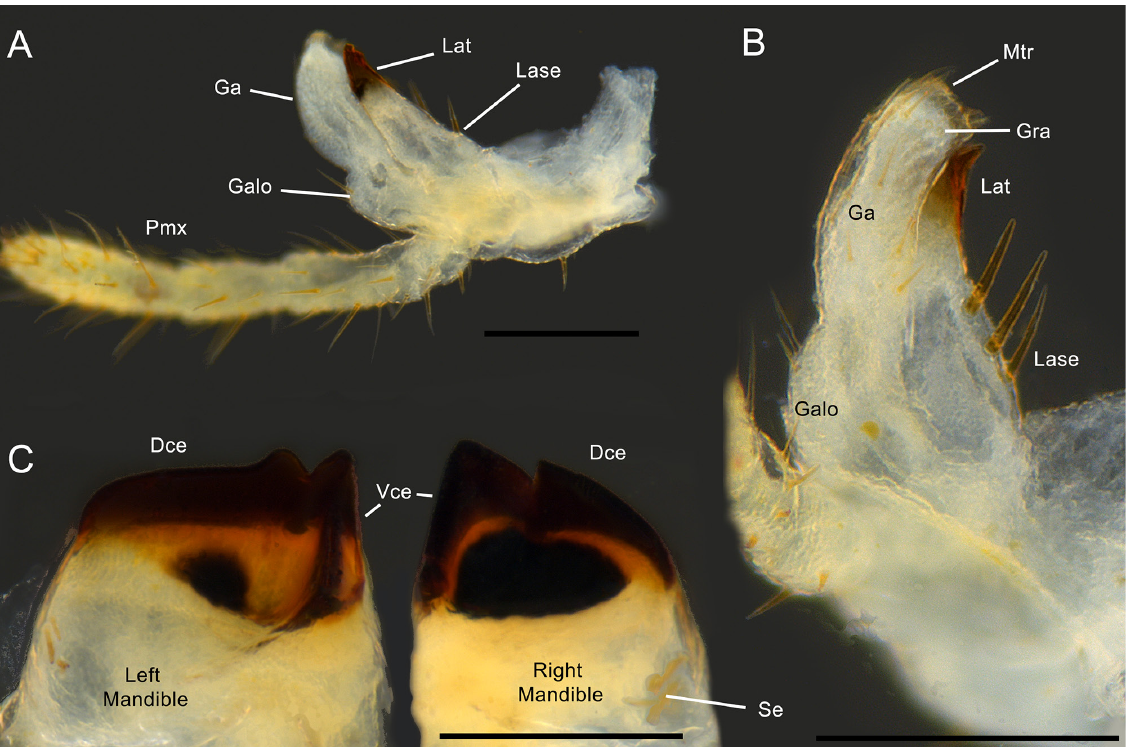
Dce = dorsal cutting edge; Ga = galea; Galo = galealobulus; Gra = granules; Lase = lacinial setae; Lat = lacinial teeth; Mtr = microtrichia; Pmx = maxillary palpus; Se = setae; Vce = ventral cutting edge. Scale bars: 0.2